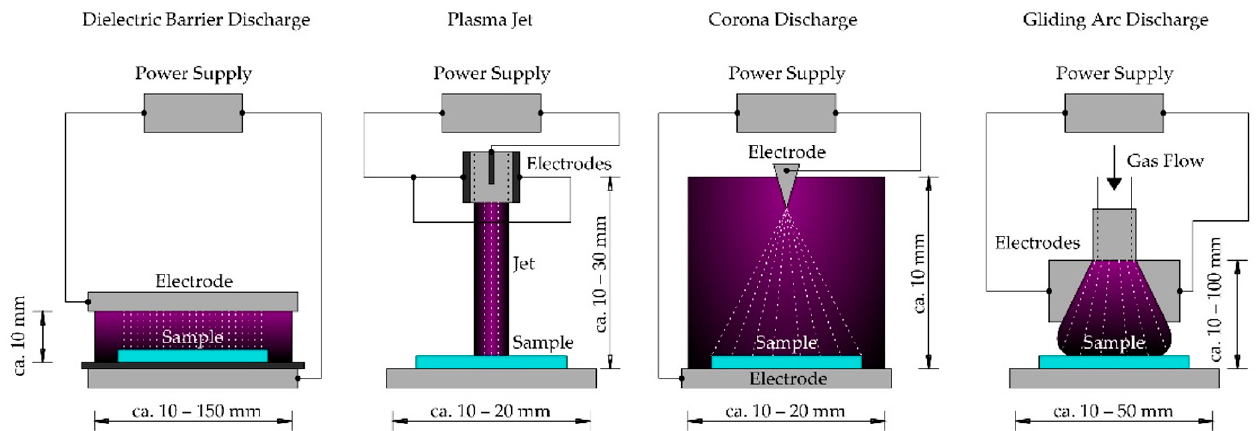
Figure 1. Types of different non-thermal plasma generating devices ( adapted from Domonkos et al. [12]). et al.